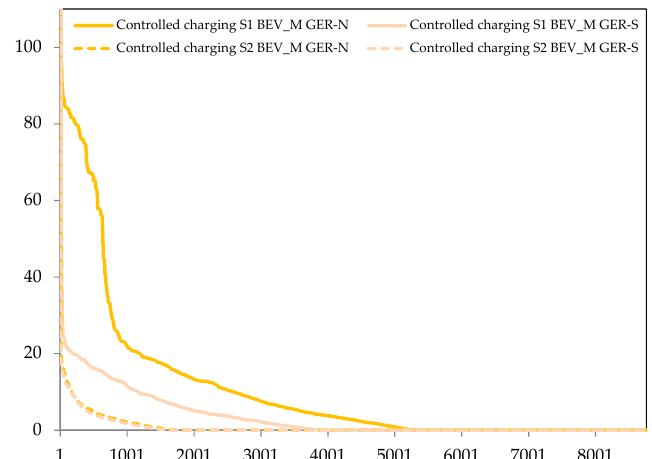
Figure A14. Duration curves of the marginal value of controlled charging for medium-sized BEV in Germany-North and -South.